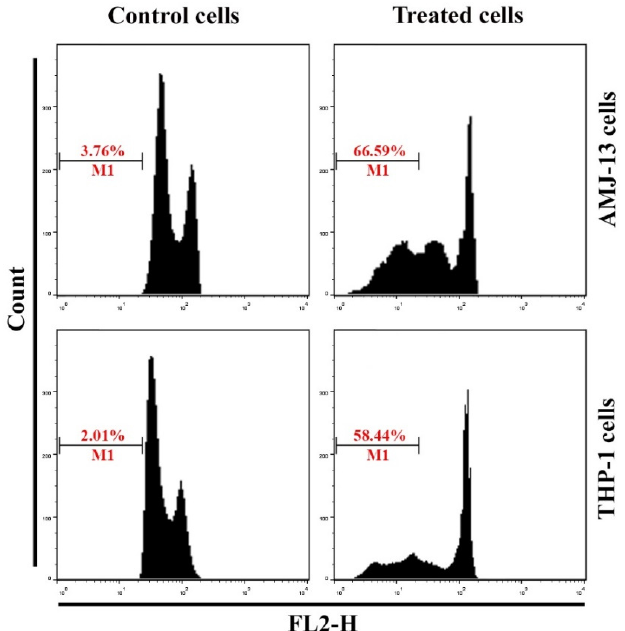
Figure 4. Apoptotic markers in AMJ-13, THP-1, and HBL cells treated with AgNPs at IC 50 ( 17.34 μ gmL − 1 ) for 24hr and stained with AO/EtBr for 1 min. Untreated cells are shown with a normal structure. However, after treatment with AgNPs, apoptotic features are observed; the red color indicates apoptosis. Scale bar 10 μ m.